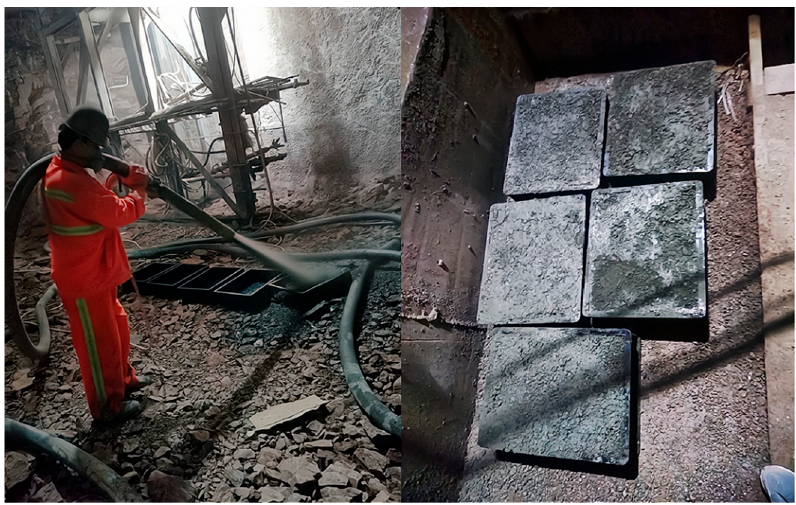
Figure 3. The preparation of on-site shotcrete slab.